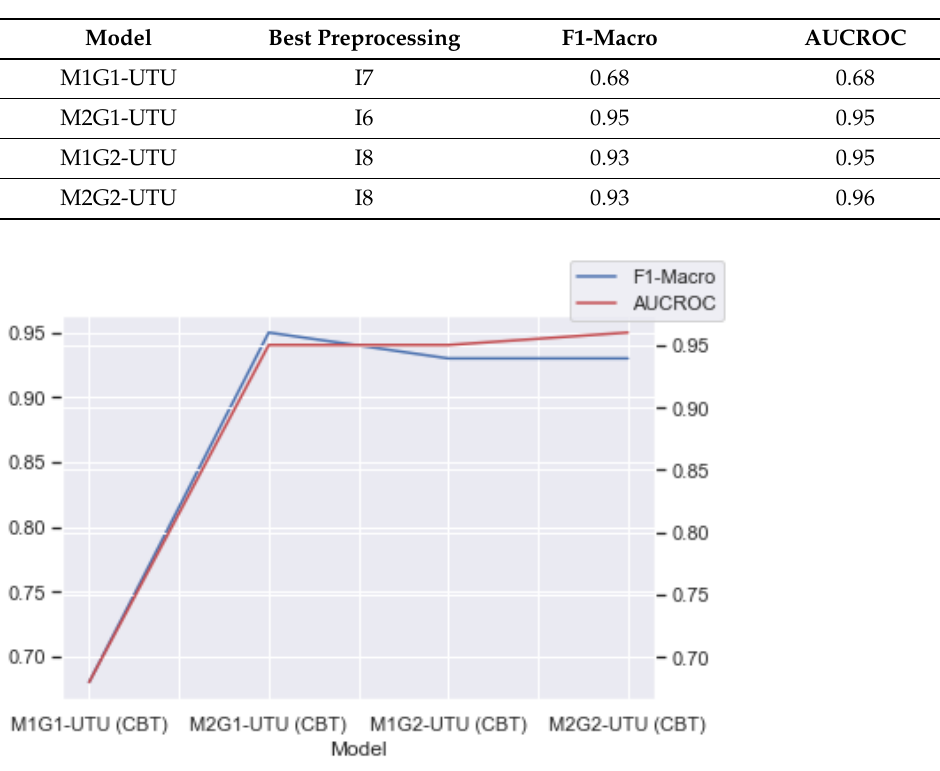
Table 6. Best results for UTU predictive models.